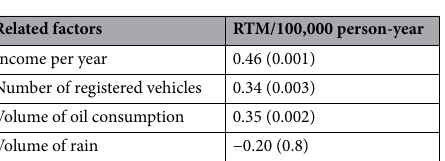
Table 4. Correlations between road traffic mortality (RTM), and related factors during 2011–2021.